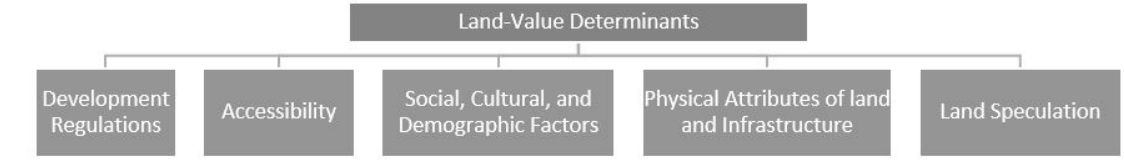
Figure 1. Land-Value Determinants – Source: (Francis,